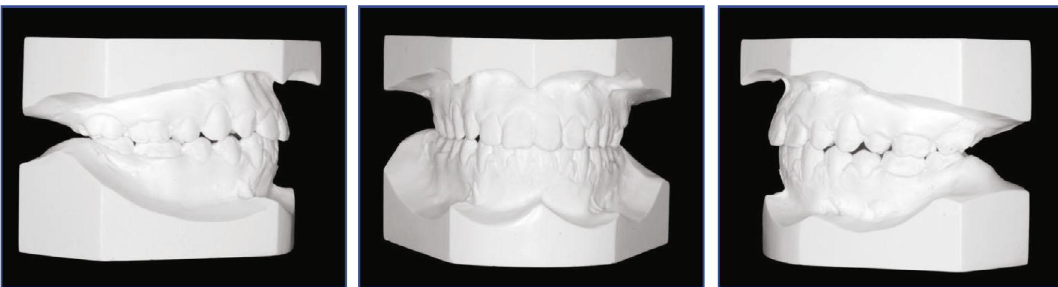
Figure 15: Posttreatment dental casts.